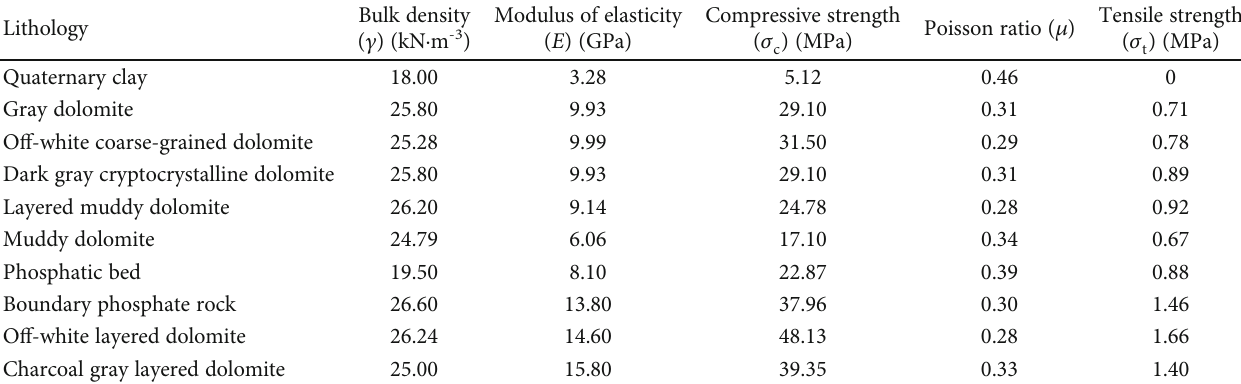
Table 1: Rock mechanical